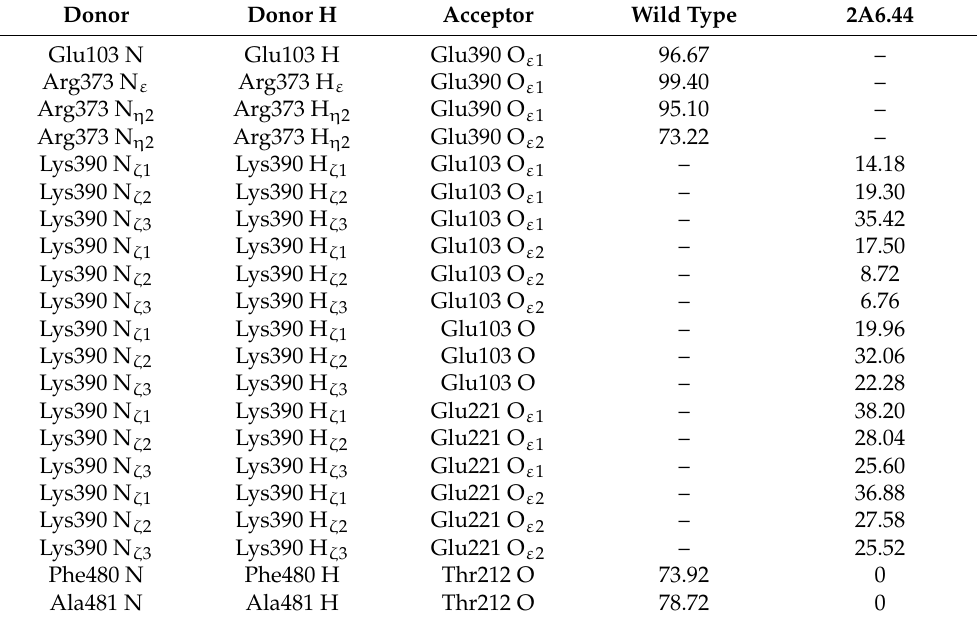
Table 9. Hydrogen bond formation involved in the structural change in